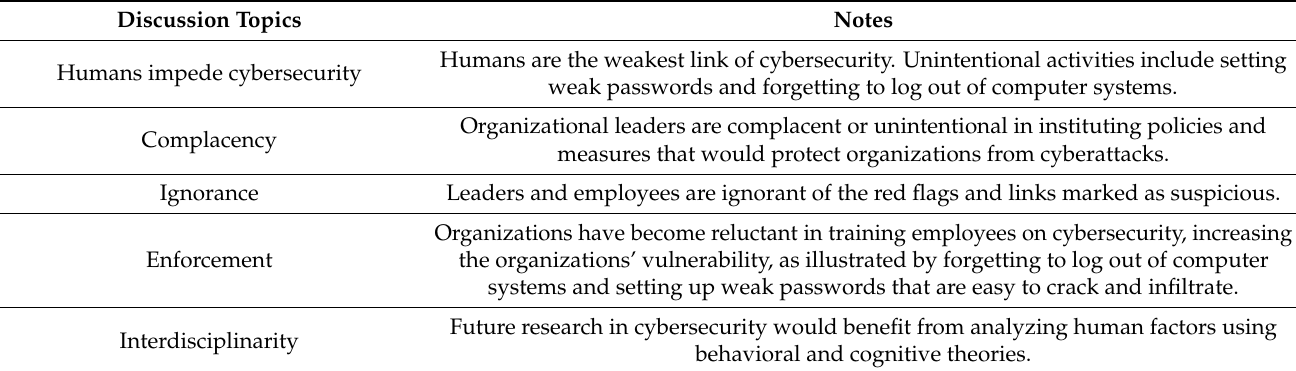
Table 3. A discussion